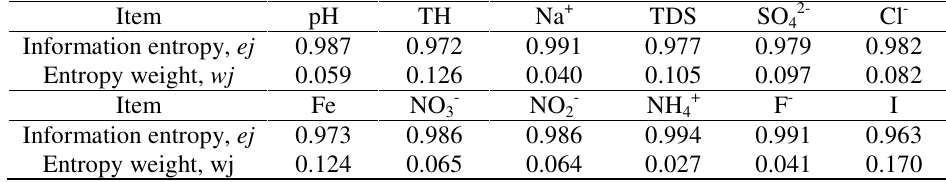
Table 2. Entropy weight of hydrochemical parameters